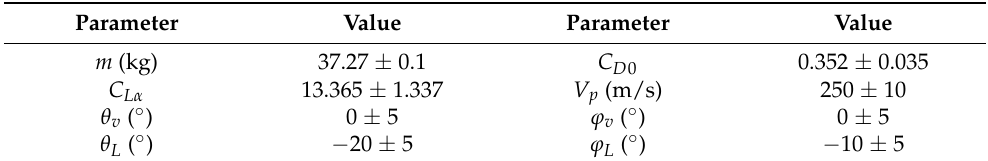
Table 6. Monte Carlo simulation parameters.